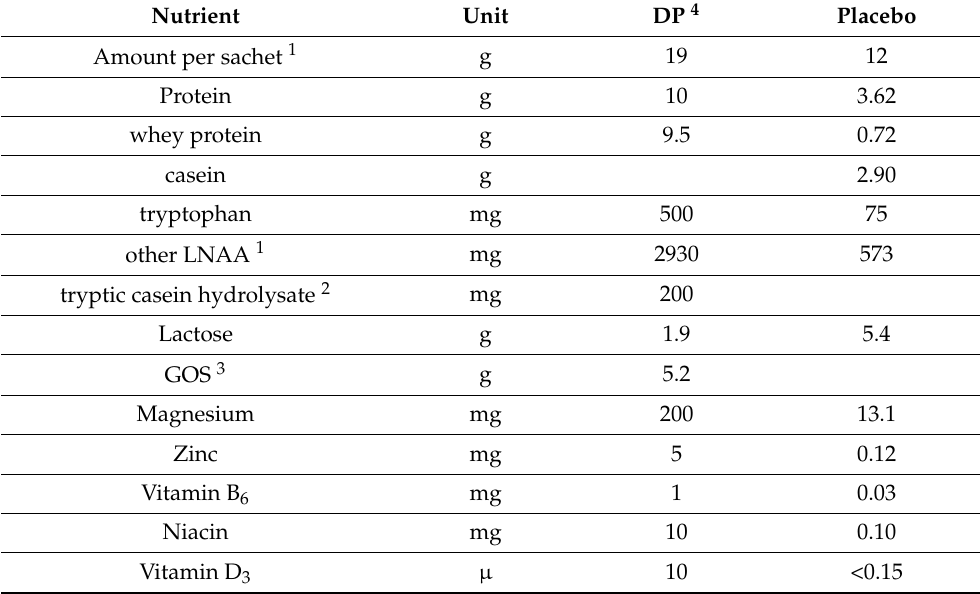
Table 1. Composition of study